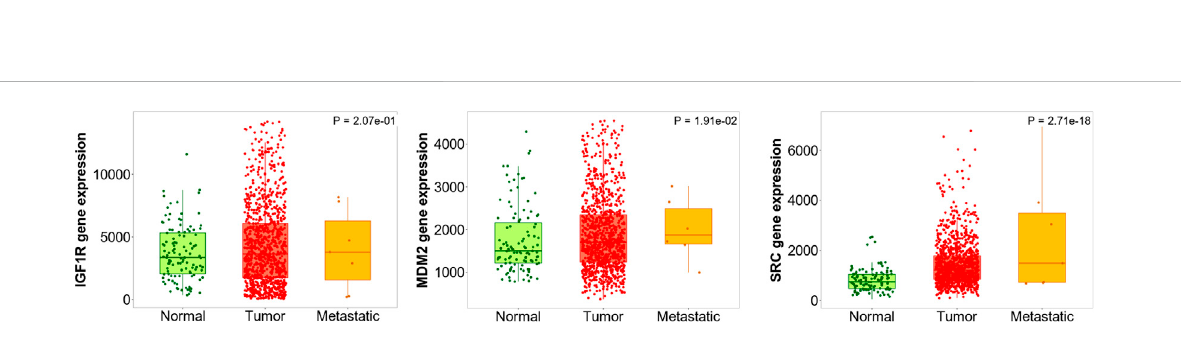
FIGURE 13 Differential geneexpressionanalysisof IGF1R , MDM2 ,and RSC intumor,normalandmetastatictissues.Diosgeninwaspredictedtopossessthe highest binding af fi nity with these